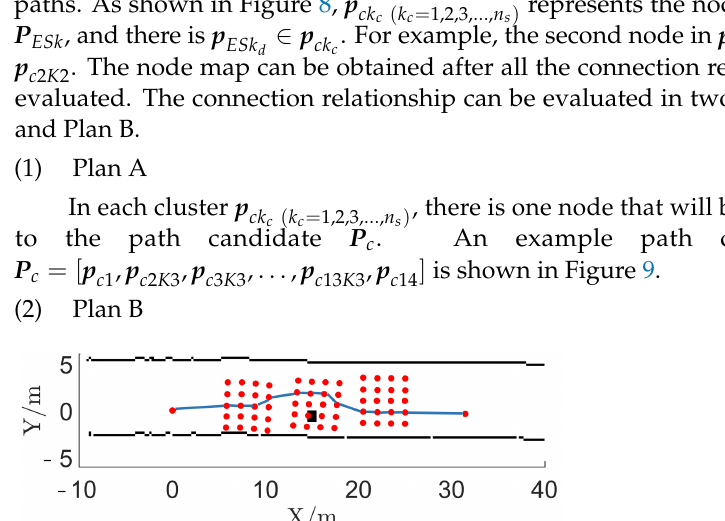
Figure 9. An example of P c generated by strategy Plan A.